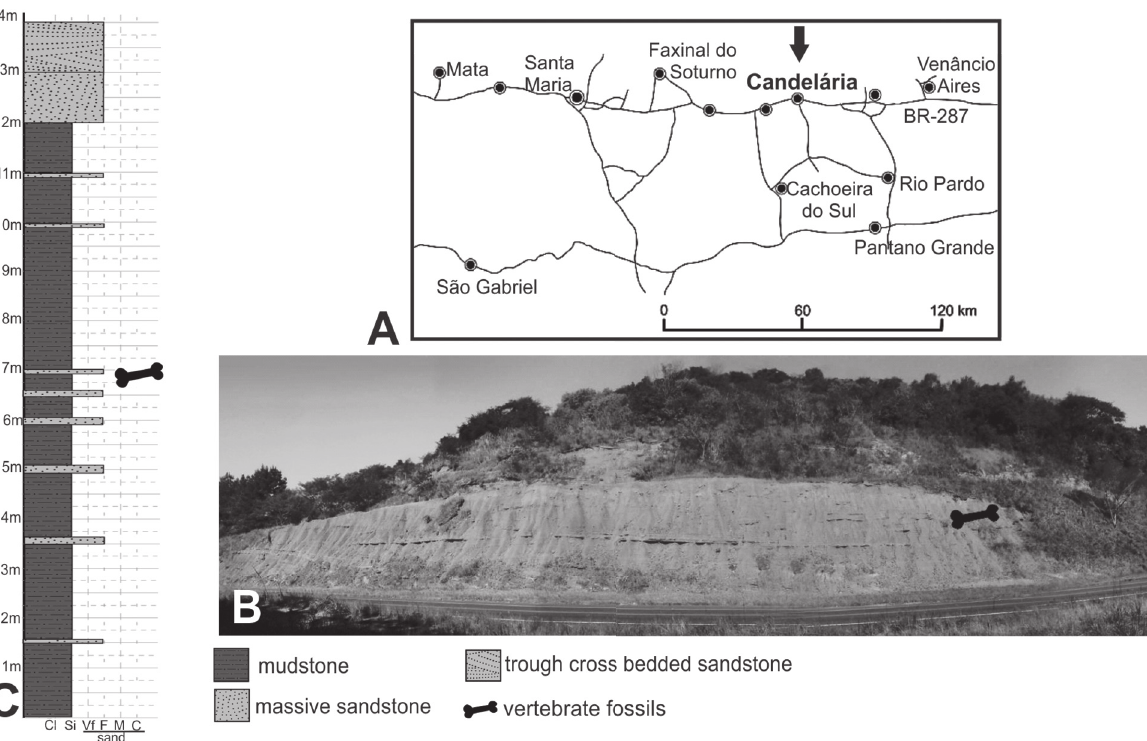
Fig. 2 - A: Road map with City of Candelária indicated. B: View of the Botucaraí Hill site, southern margin of BR 287 road, with the indication of the fossiliferous level. C: Log of the Botucaraí Hill